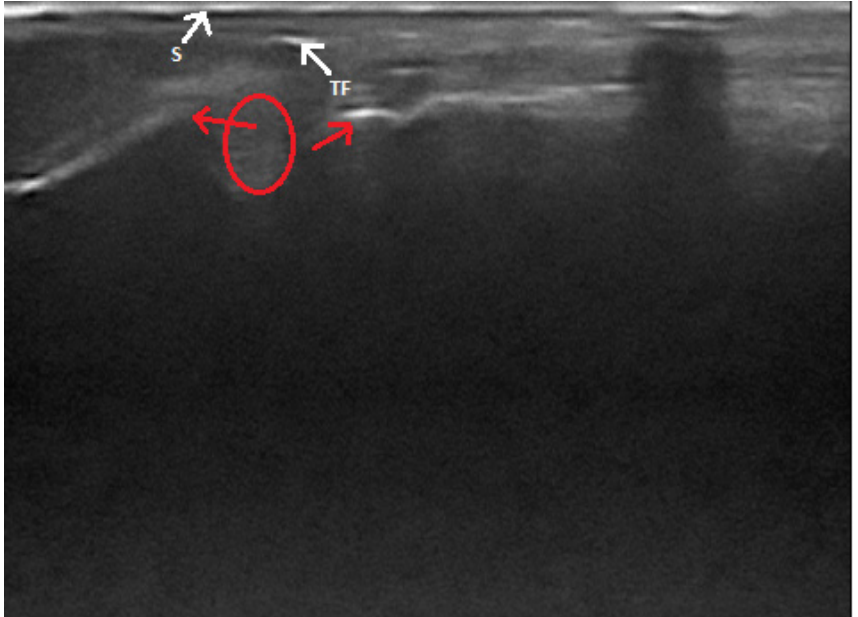
Figure 4. Ultrasonographic image of total Achilles tendon rupture. Ends of the torn tendon (red arrows), a hematoma (circle), a fragment of a tendon (TF) and the skin surface (S) is shown. Magnetic resonance imaging allows for the visualization of tendons and adjacent soft tissue structures in high resolution, multiplanar images (Figure 5). A case report by Lin et al. [47] is the first and only description of the use of MRI in the diagnosis of an Achilles tendon injury in a dog. The tissue at the site of the tendon tear is homogeneous and hyperintense in T2-weighted images, which is similar to previously reported findings in human medicine [48–51]. The authors also observed the thinning and displacement of tendon fragments and foci of post-contrast enhancement at the site of the injury [47].